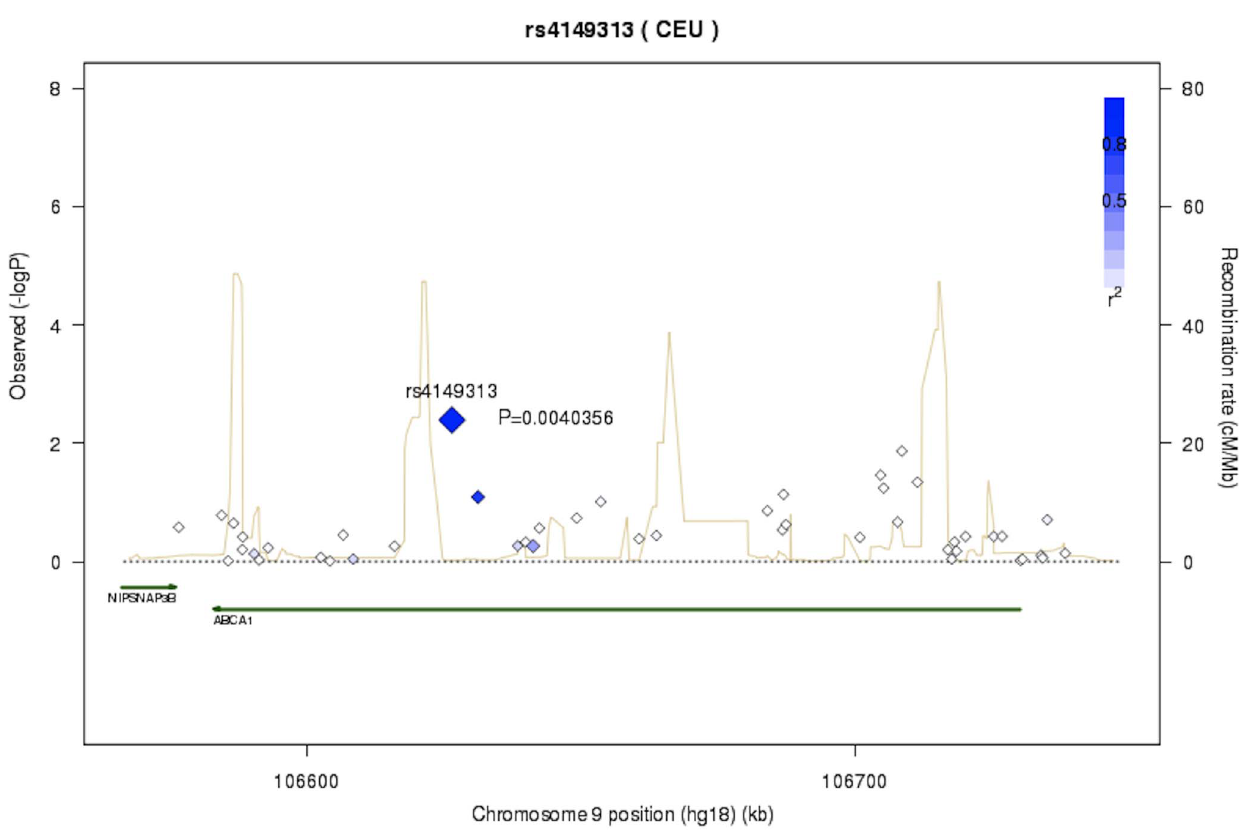
Figure 3. Region plot of the ABCA1 locus (chromosome 9 co-ordinates 106157871–107157392) in the Swedish Twin Registry. The SNP rs4149313 with the strongest association is marked by a bright blue diamond. Each rhomb represents a SNP and the brightness represents the extent of linkage disequilibrium with the lead SNP. The recombination rates are marked with yellow lines. Relevant genes and genomic coordinates are shown below the plots. Plots were generated using SNAP (http://www.broadinstitute.org/mpg/snap/ldplot.php. Accessed 2013 Mar 1.) and based on HapMap CEU release 22, NCBI B36 assembly, dbSNP build 126.